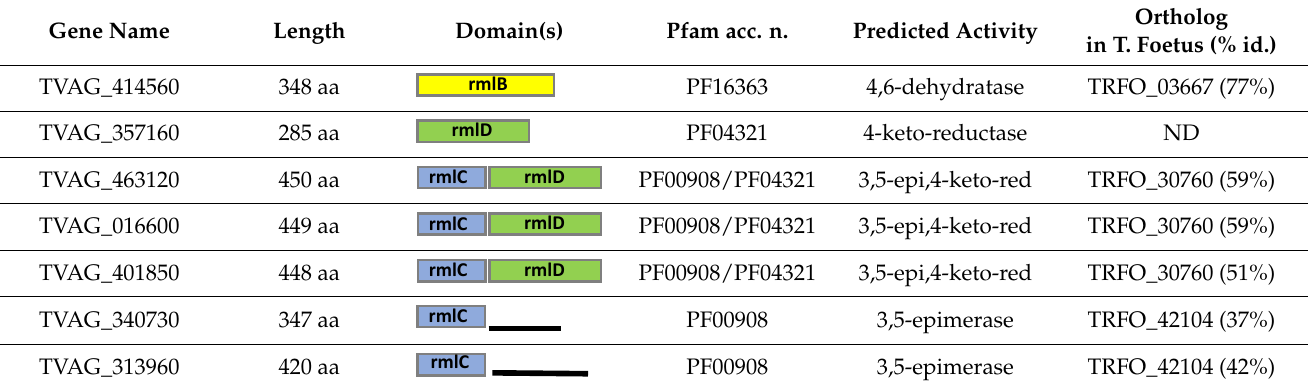
Table 1. Sequences identified in the T. vaginalis genome by BLAST analysis using enzymes of the NDP-L-rhamnose pathways in Bacteria, Eukaryota, and giant viruses. ND, not detected.